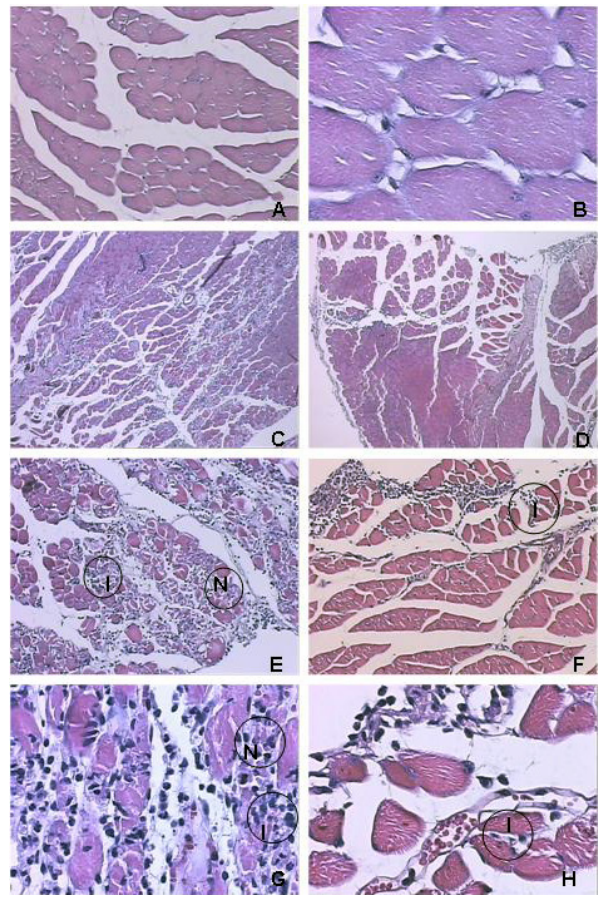
Figure 3. Histopathological analysis. Light micrographs of sections of mouse gastrocnemius muscle 24 hours after injection of 20 μg BmooMtx, dissolved in 50 μL saline, stained with hematoxylin- eosin. (A, B) Control mice were injected with saline alone: normal integral fibers are observable. (C, E, G) BmooMtx. (D, F, H) BmooMtx preincubated for 120 minutes at 37°C with anti-BmooMtx antibodies at the ratio 1:50. Notice the presence of necrosis (N) and an abundant inflammatory infiltrate